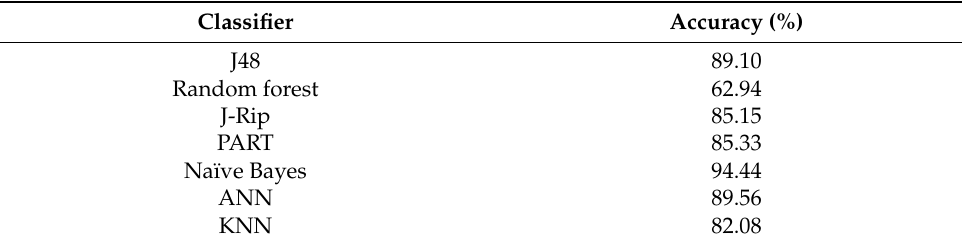
Table 3. The accuracy of seven classifiers in the first classification stage.